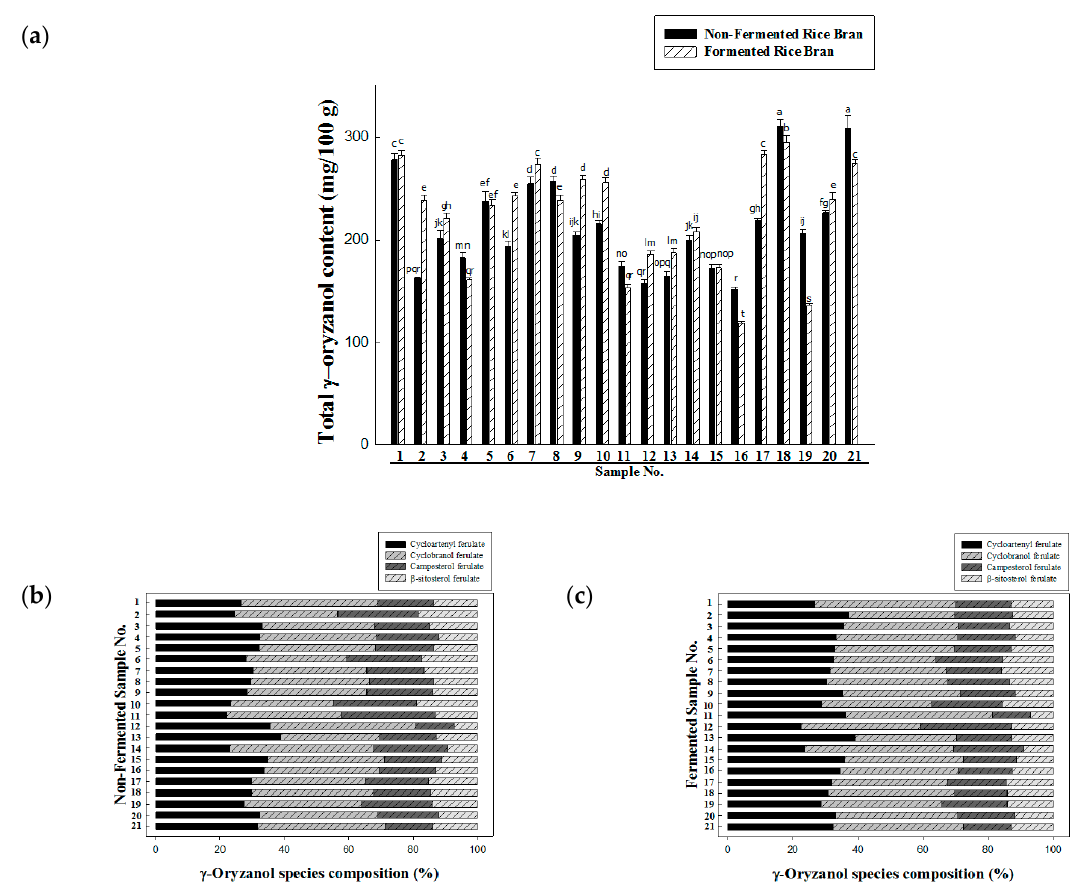
Figure 1. Total γ -oryzanol content. Comparison of non-fermented and fermented rice bran ( a ); composition of γ -oryzanol species of non-fermented rice bran ( b ); and fermented rice bran ( c ).